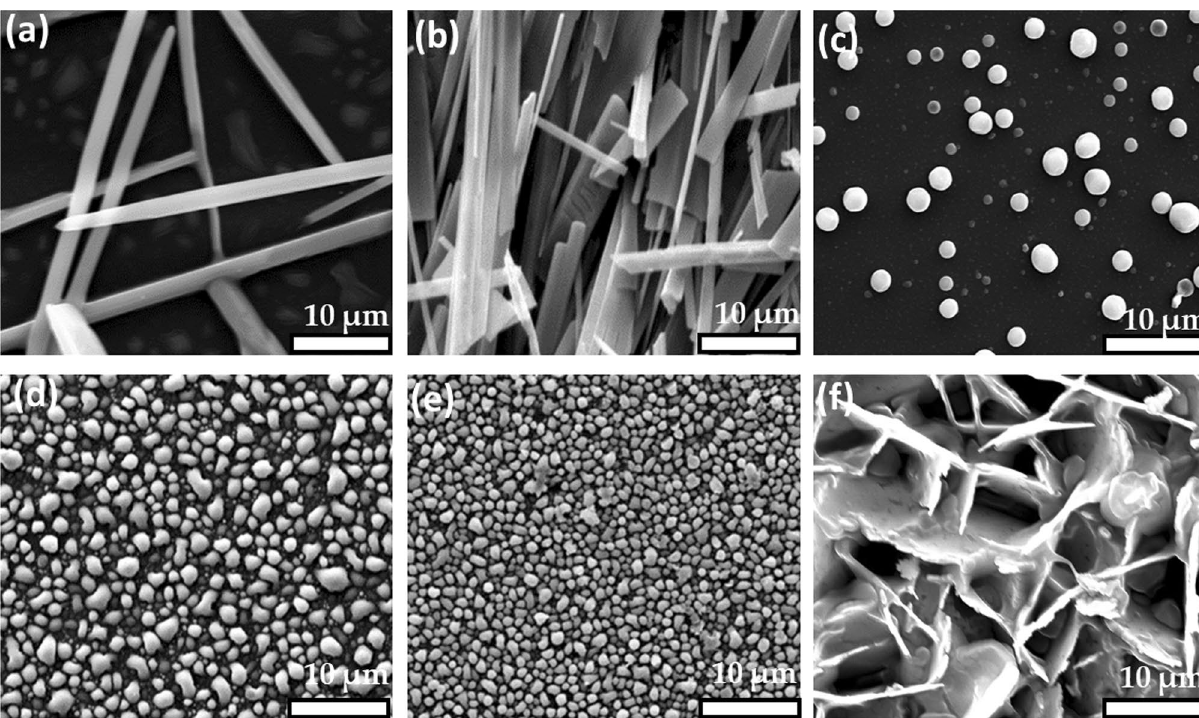
Figure 6. Representative SEM images of Cu 2x Sb 2(1−x) S y thin film synthesised by the hot-wall AACVD at 450 °C using various values of x, where x = ( a ) 0, ( b ) 0.2, ( c ) 0.4, ( d ) 0.6, ( e ) 0.8 and ( f ) 1. These were recorded at 15 k eV using secondary electron